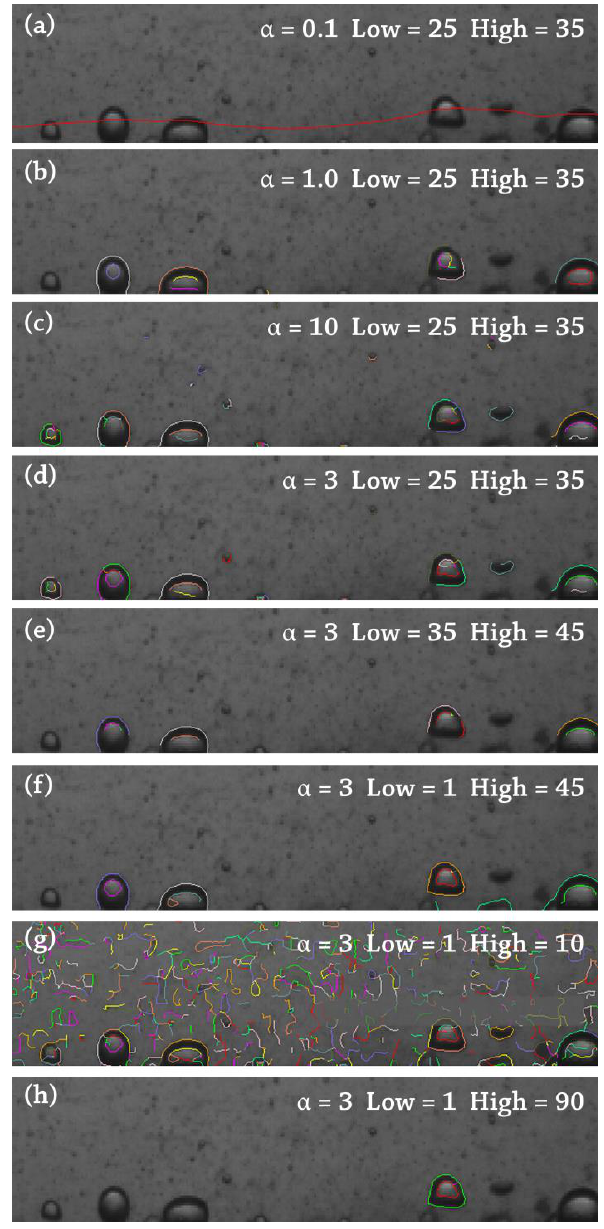
Figure 8. Filter value examples for the side projection. Sensors 2017 , 17 , 1448